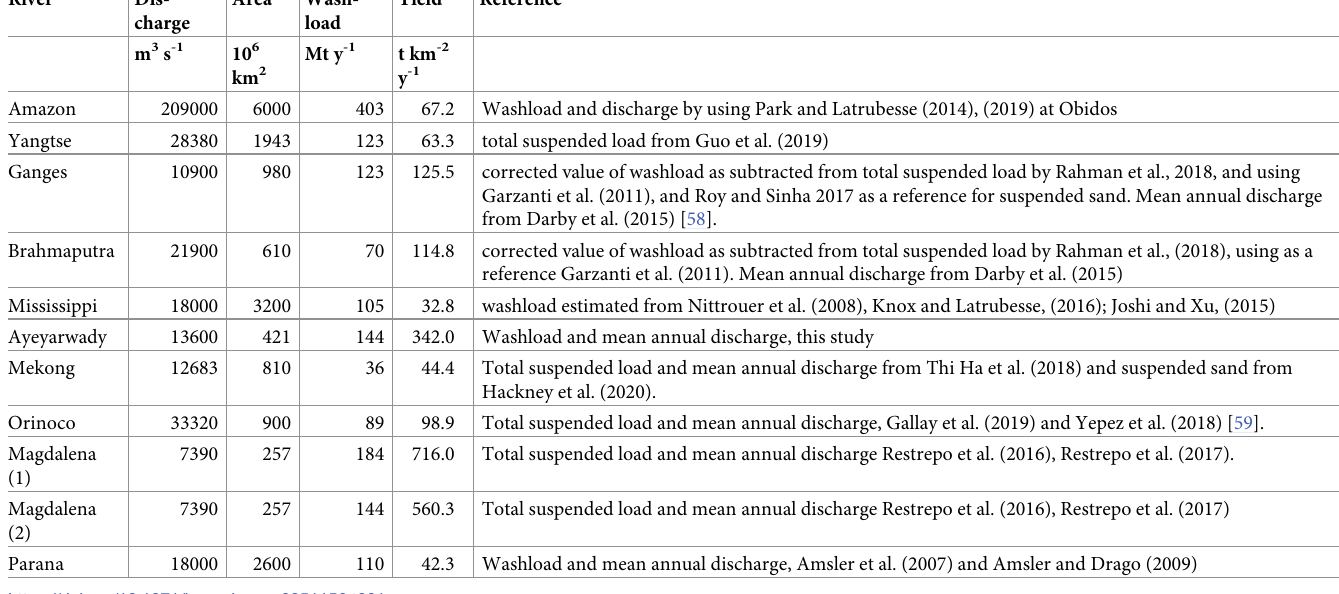
Table 1. Current annual washload of the world’s largest